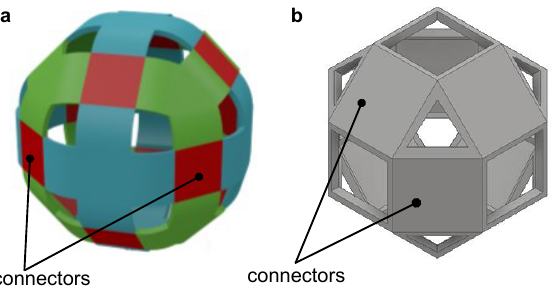
Figure 2. Catom’s CAD structure. ( a ) Quasi-spherical catom shape. ( b ) Catom maximizing the surface of